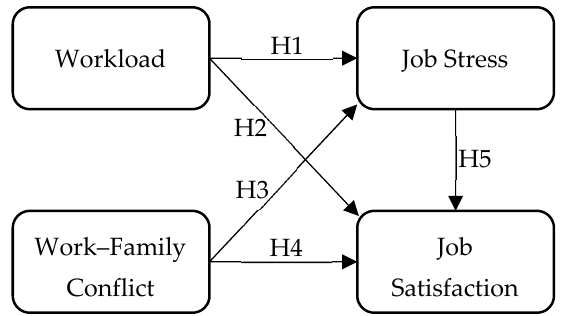
Figure 1. A theoretical model of employee satisfaction.